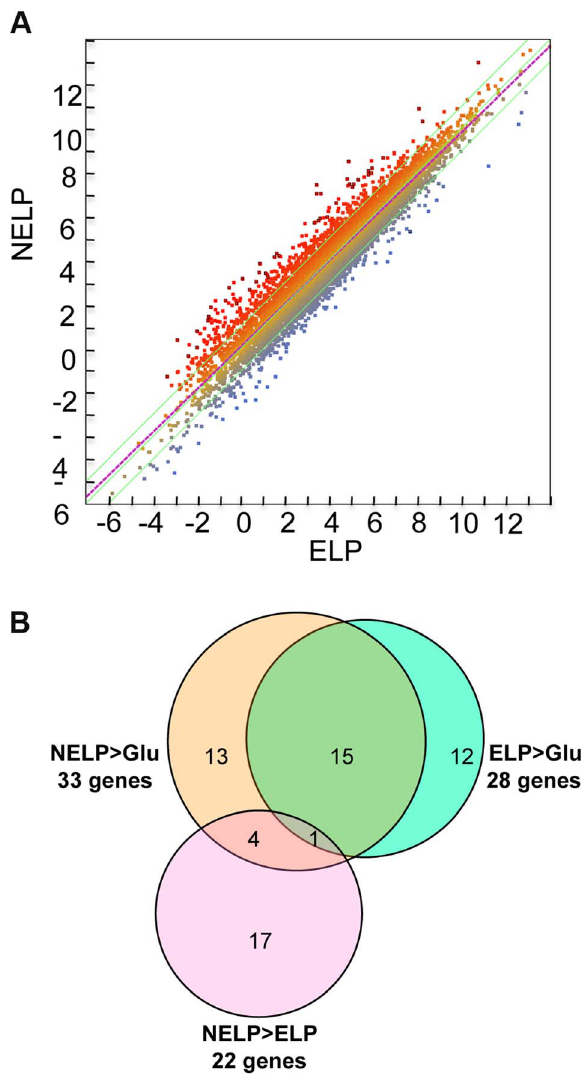
Figure 7. P. gigantea transcriptome. Scatterplot (A) shows the distribution of RNA-seq RPKM values (log 2 ) for 11,376 P. gigantea genes when grown on basal salts containing acetone-extracted loblolly pine wood (ELP) or non-extracted loblolly pine wood (NELP). Lines define 2- fold borders and best fit regression. Darkened points represent 44 transcripts accumulating . 4-fold at p , 0.01. Venn diagram (B) illustrates genes with RPKM signals . 10 and upregulated . 4-fold in NELP relative to ELP. Twenty-two genes showed significant transcript accumulation in NELP relative to ELP suggesting potential response to resin and pitch content. Under these stringent thresholds (p , 0.01; . 4-fold), only one gene, a MCO model Phlgi1_129839, showed significant transcript accumulation in ELP relative to NELP. Additional detail appears in Tables 1-3. Detailed methods and complete data are presented in Text S1 and Dataset